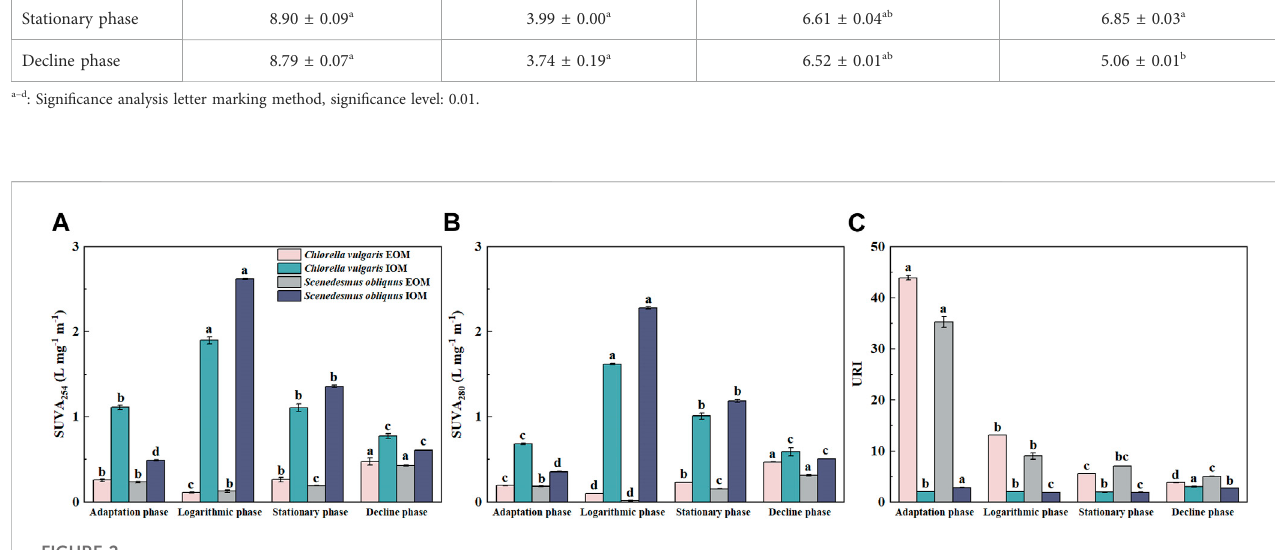
FIGURE 2 UV absorbance of Chlorella vulgaris and Scenedesmus obliquus at different growth stages. (A) SUVA 254 ; (B) SUVA 280 ; (C)